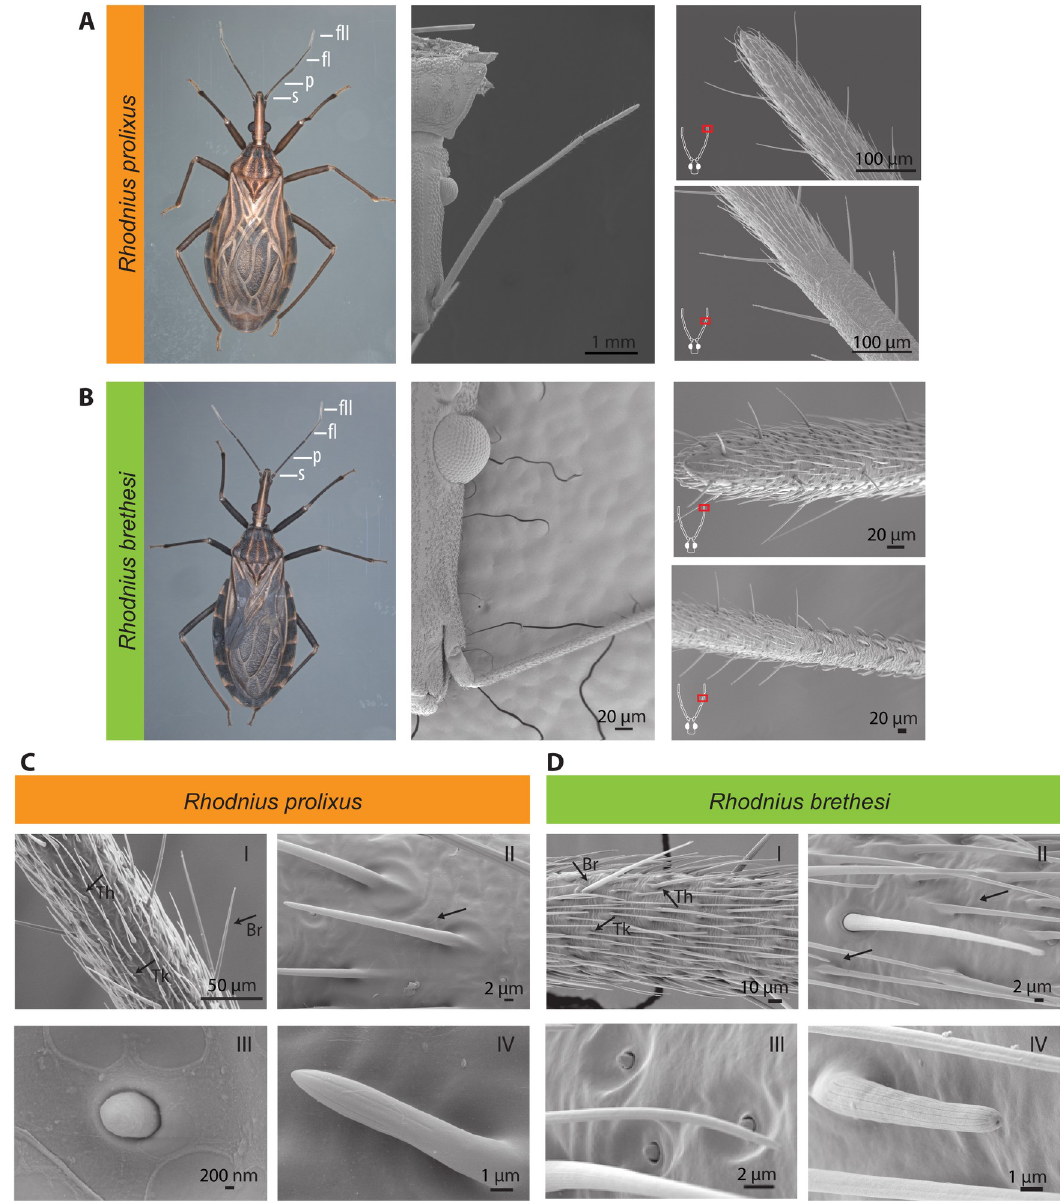
Fig 1. Morphology of the peripheral olfactory system of Rhodnius prolixus and Rhodnius brethesi . (A,B) Light-microscopic images of whole body of R . prolixus and R . brethesi (left panel). Antennal segments indicated: scape (s), pedicel (p), flagellomere I (fI), and flagellomere II (fII). Scanning electron microscopy (SEM) images of head (middle panel) and corresponding antennal segments (right panel). (C,D) Antennal sensilla of R . prolixus and R . brethesi on flagellomere II: arrows indicate (I) thick-walled (Tk), and thin-walled (Th) trichoid sensilla (also known as trichoid and basiconic sensilla), and bristles (Br). (II) Thick-walled trichoid sensillum, (III) campaniform sensillum, and (IV) grooved peg sensillum.